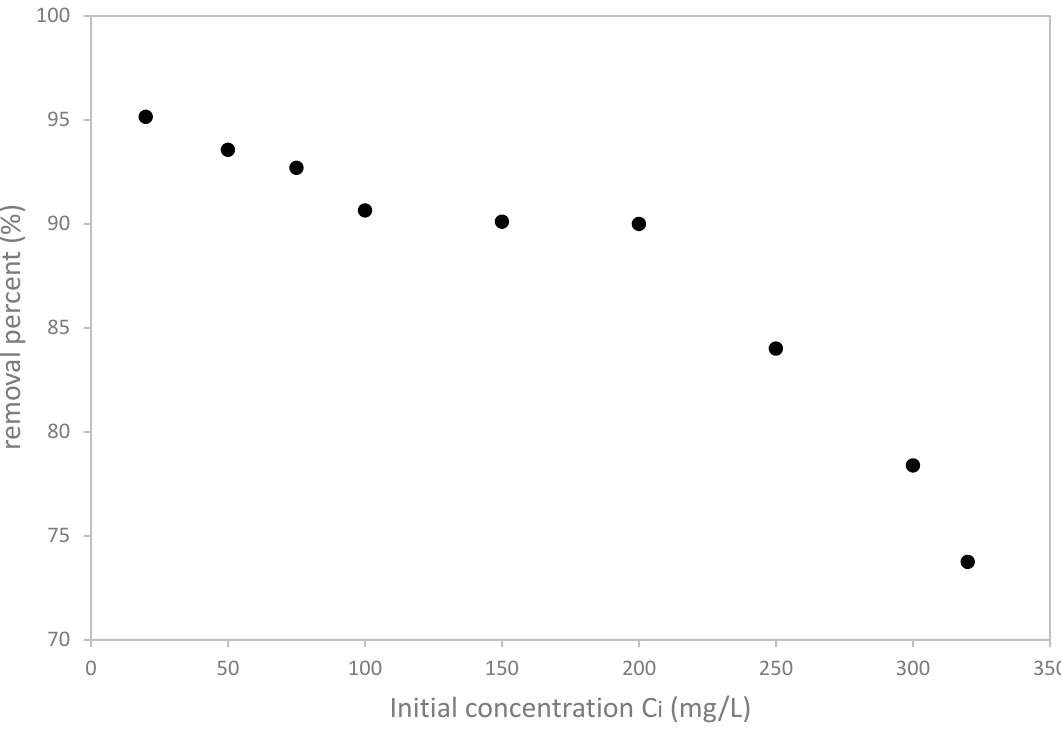
Figure 6. Effect of the initial concentration of copper on its removal yield by olive pomace.